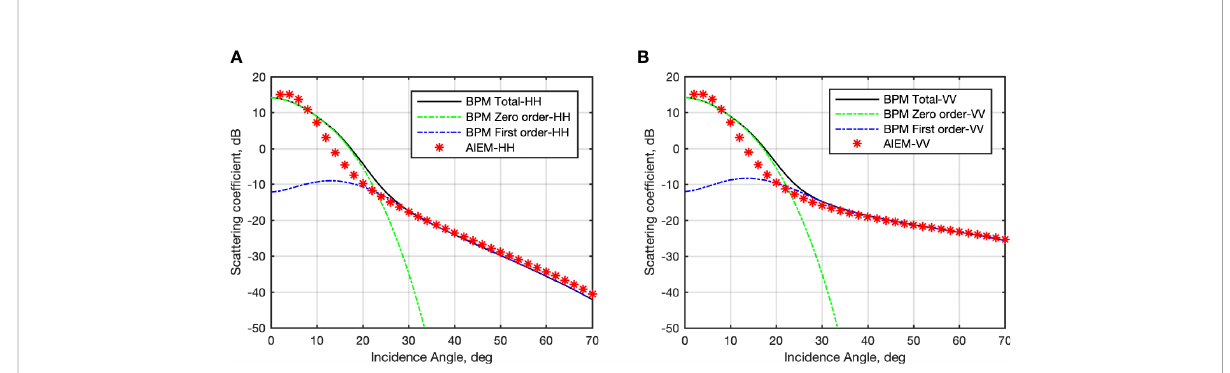
FIGURE 1 (A) HH- and (B) VV-polarized X-band backscattering coef fi cients related to a slick-free sea surface predicted by two-scale BPM (continuous black lines) and AIEM (red asterisks) under a wind speed U 10 =5 ms − 1 at variance of incidence angle. The zero ( fi rst)-order BPM scattering coef fi cients are also annotated as dashed green (blue)